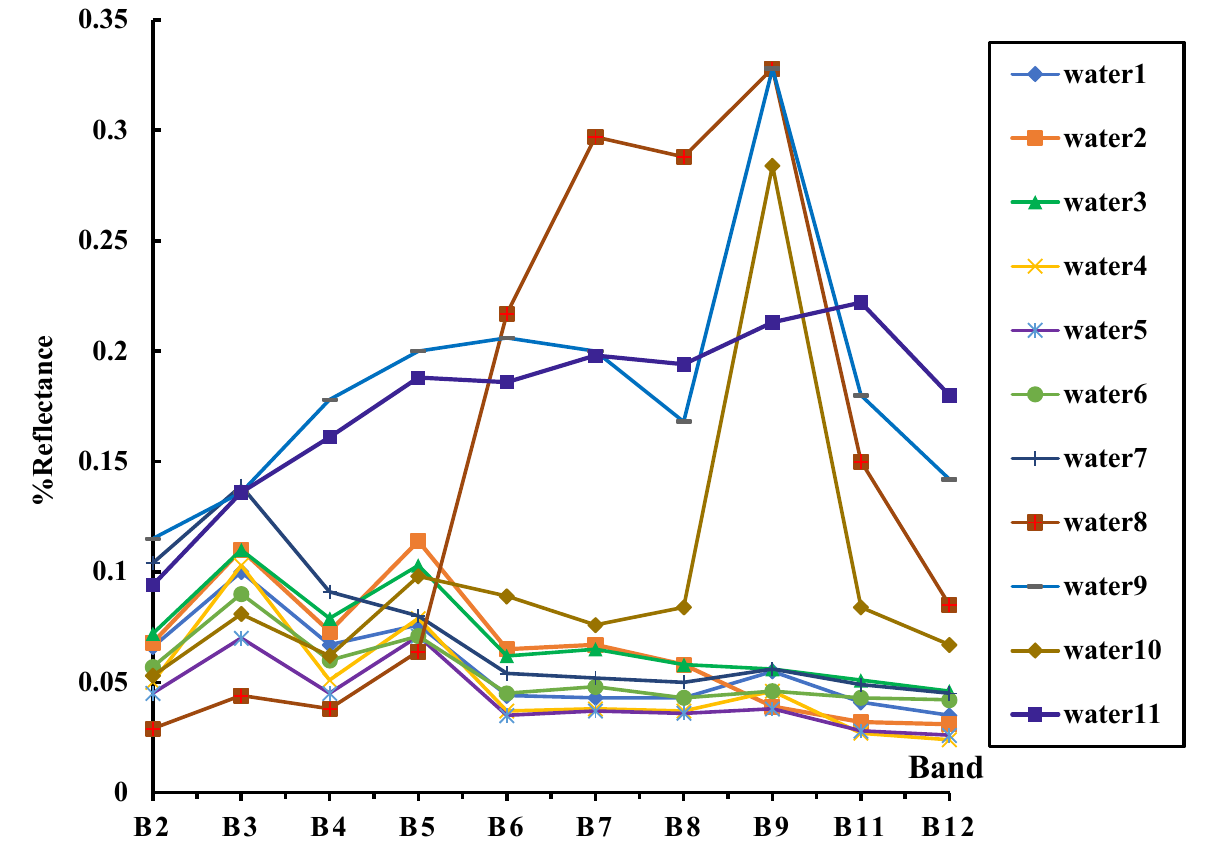
Figure 2. Reflectance values of different water bodies in all Sentinel-2 wavebands apart from B1, B8A, and B10.